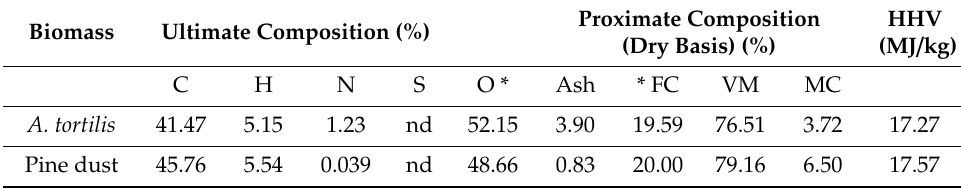
Table 2. Characterization results: ultimate, proximate and higher heating value